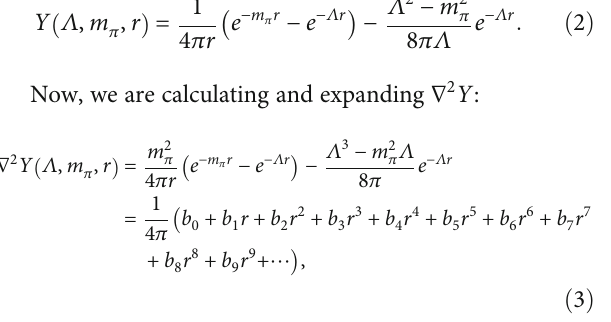
Figure 1: (color line) The s -wave charmed baryons with J p = 1/2 + and pseudoscalar or vector s -wave charmed mesons which form the molecular baryons with double charm [6].